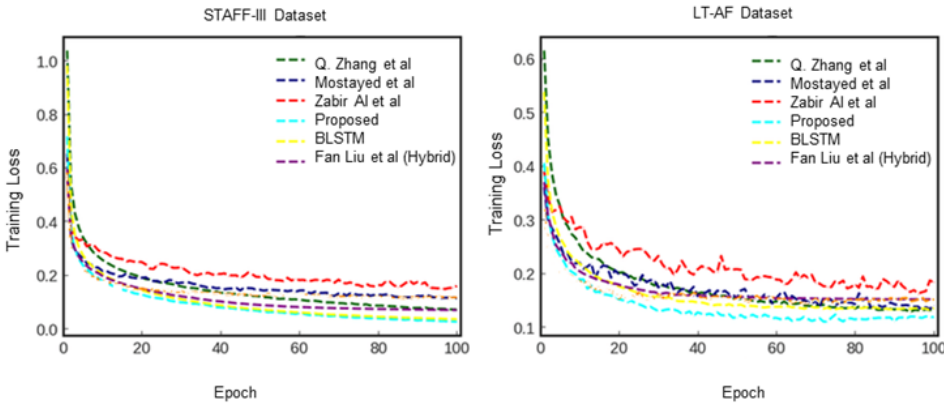
Figure 11. Comparison of cross-entropy loss per epoch over STAFF-III dataset and LT-AF dataset.